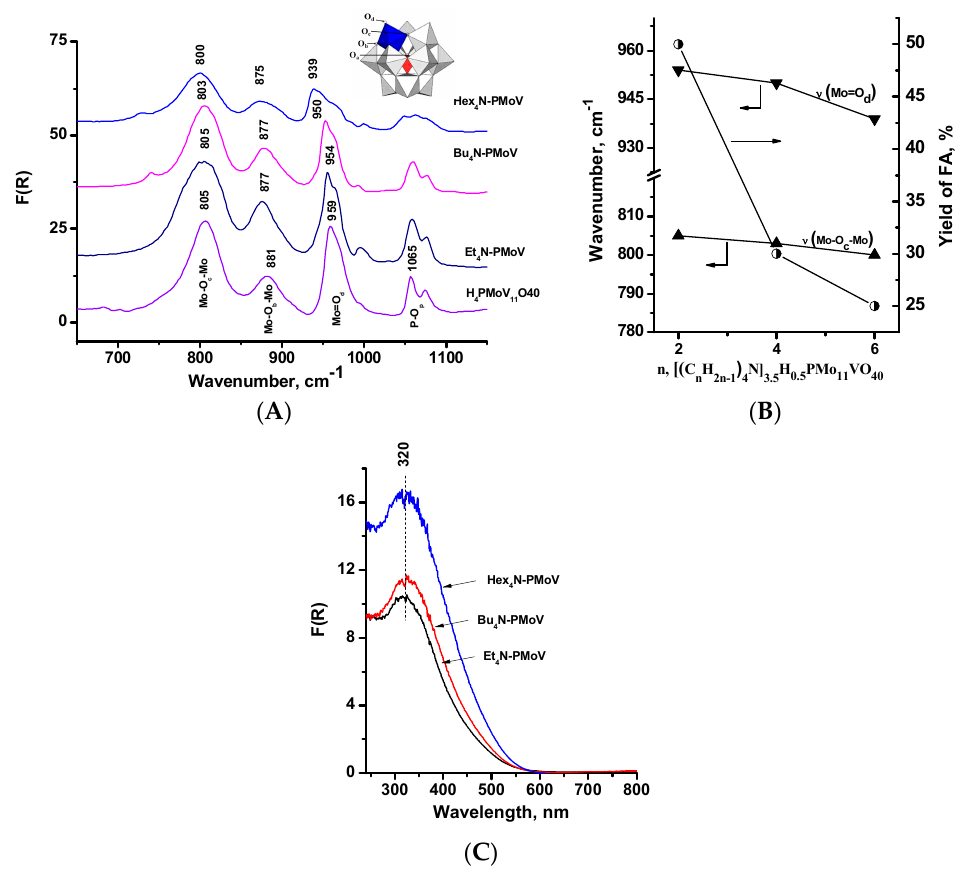
Figure 1. ( A ) IR spectra of H 4 PMo 11 VO 40 , R 3.5 H 0.5 PMo 11 VO 40 (R-Et 4 N, Bu 4 N and Hex 4 N); ( B ) Effect of the alkyl group length in cation of R 3.5 H 0.5 PMo 11 VO 40 on ν as (Mo=O d ), ν s (Mo-O c -Mo) and yield of FA; Table 1. Textural and acidic properties of solid HPA catalysts.